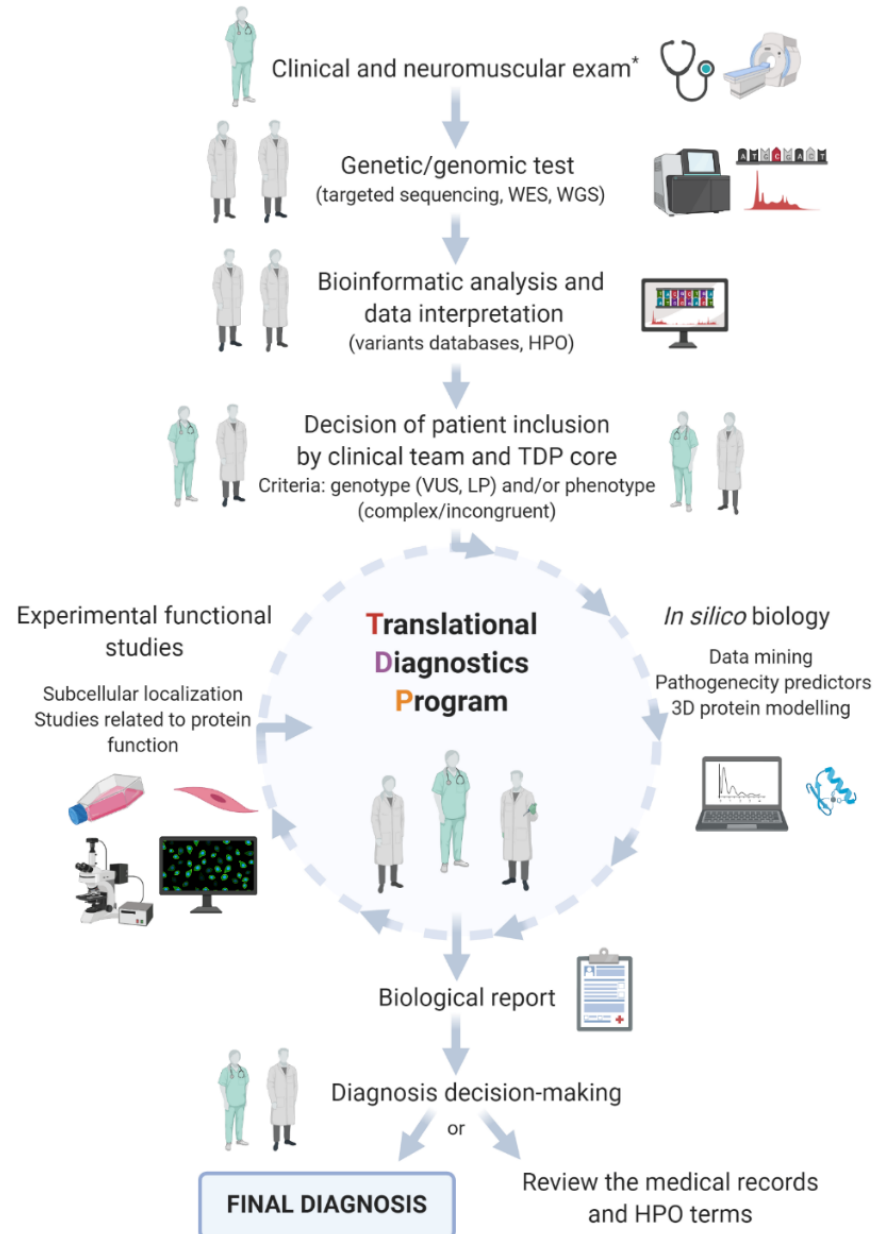
Figure 1. In-house Translational Diagnostics Program (TDP) flow diagram in neuromuscular diseases . First of all, a precision phenotyping by a clinical and neuromuscular exam is performed in the patients. After, the most appropriate genetic/genomic test is selected. The bioinformatics analysis and data interpretation are carried out using a pipeline developed in our department. In this step, if diagnosis is not achieved, the clinical team and the TDP core team decide the patient’s inclusion in the study into the TDP. When the case is accepted, firstly, in silico biology of the variant are performed (literature review and data mining, pathogenicity predictors, and 3D-protein modelling). Secondly, functional validation studies are performed by reliable molecular, cellular, and imaging assays related to specific protein function. After that, a final biological report is generated integrating both in silico and experimental results. In the final step, the clinical team and TDP core team evaluate all procedure steps and elaborate the final diagnostic decision. Abbreviations: HPO, Human Phenotype Ontology; LP, likely pathogenic; VUS, variant of uncertain significance; WES, whole exome sequencing; WGS, whole genome sequencing. * Anamnesis, physical examination, biomarkers, neuroimaging and pathology. Illustration created with BioRender (https://bioren- der.com).